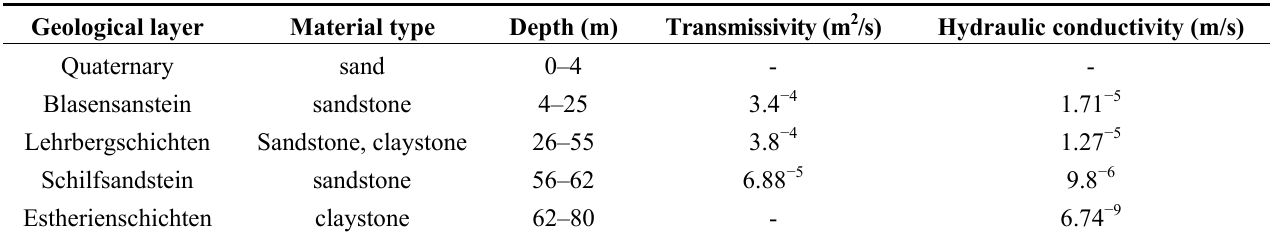
Table 2. The hydraulic properties estimated by pumping tests and permeability tests. Geological